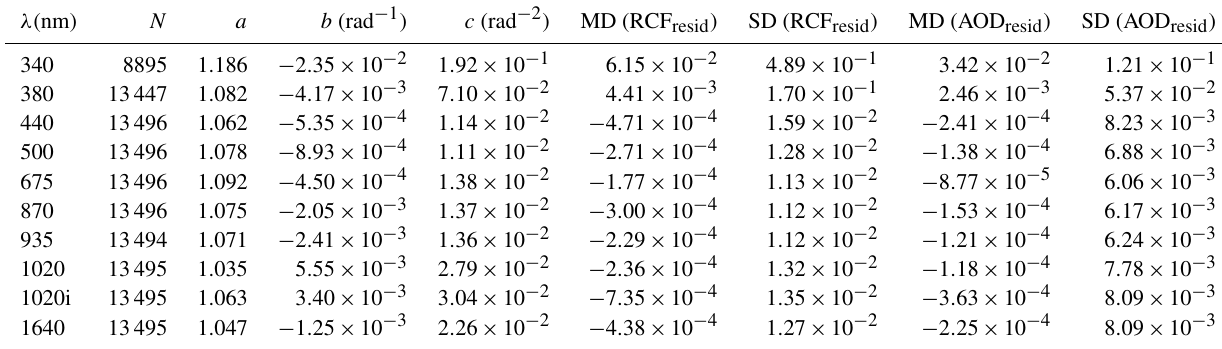
Table 1. Fitting coefficients of the RIMO correction factor (Eq. 8), the number of data used ( N ), and median (MD) and standard deviation (SD) of the residuals in the RIMO correction factor (RCF) and aerosol optical depth (AOD) for different photometer wavelengths. The fitting values at 340nm have been obtained without MPA absolute values above 55 ◦